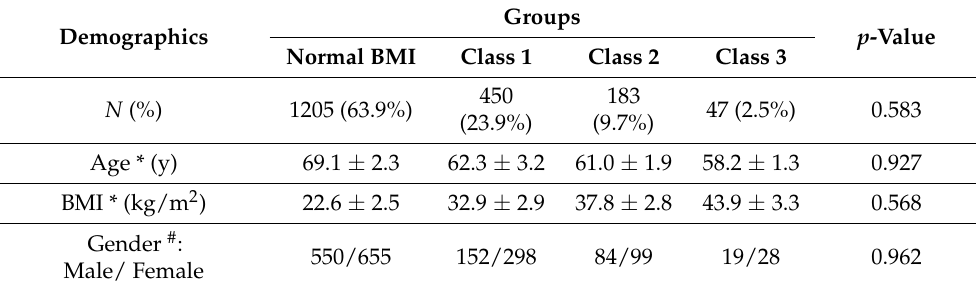
Table 1. Stage 1 of the study—patient demographics.